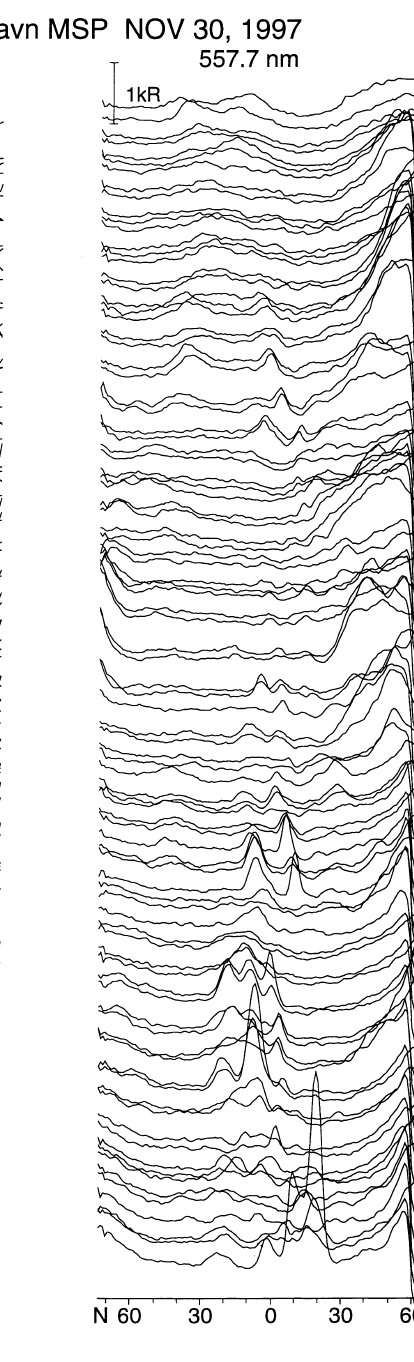
Fig. 4. MSP observations from Dan- markshavn, Greenland of auroral emissions at 630.0 and 557.7 nm for the interval 1000–1102 UT on No- vember 30, 1997